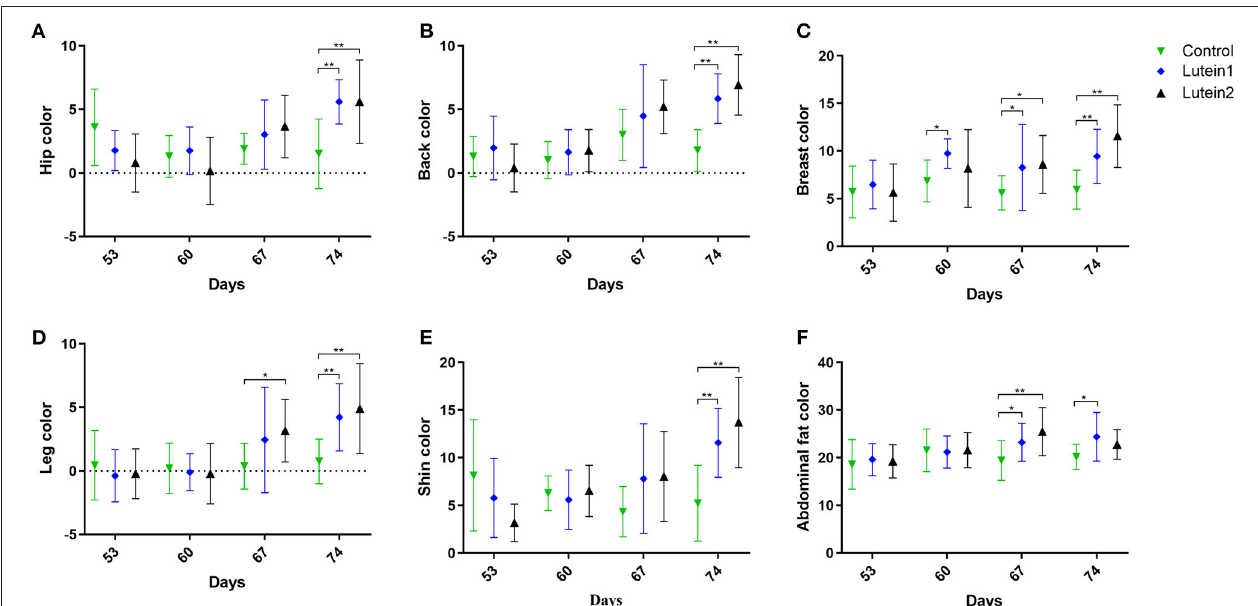
FIGURE 1 | Yellowness measurement of yellow-feather chickens at 53, 60, 67 and 74 days of age. (A) Yellowness of the hip. (B) Yellowness of the back. (C) Yellowness of the leg. (D) Yellowness of the breast. (E) Yellowness of the abdominal fat. (F) Yellowness of the shin. * P < 0.05; ** P < 0.01; n = 10.